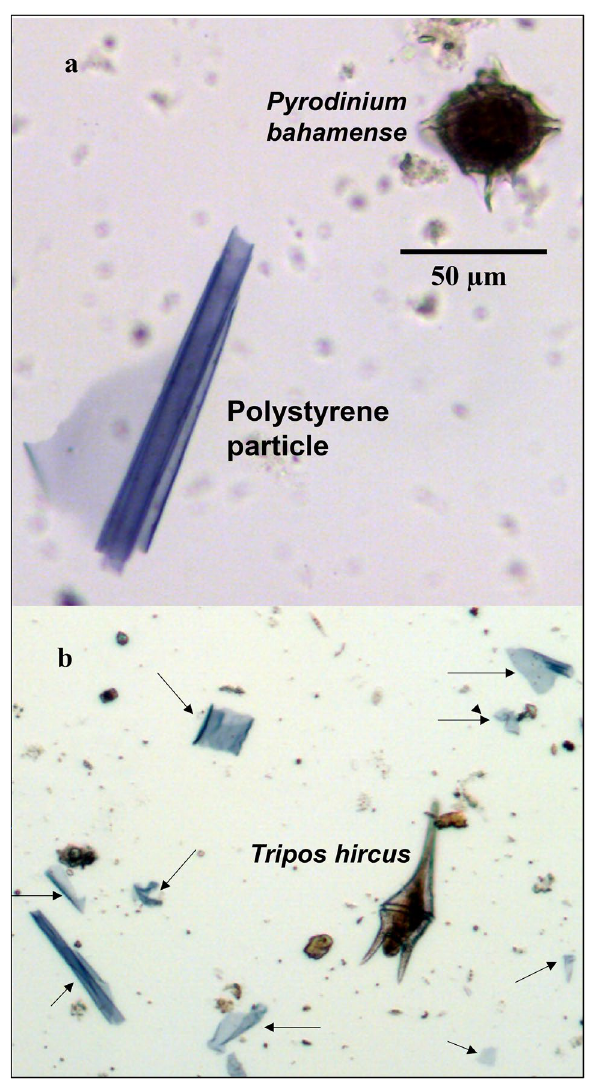
Figure 2. Microscopic image (×400 magnification) of a Pyrodinium bahamense cell and polystyrene particle in water sample ( a —top panel), and microscopic image (×100 magnification) of a broader view of multiple polystyrene particles including the dinoflagellate Tripos hircus . Arrows indicate the location of polystyrene particles ( b —bottom